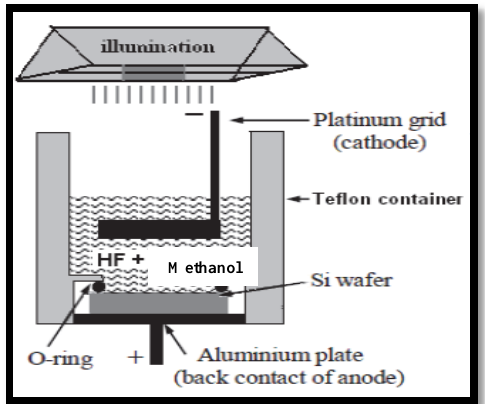
Fig.2: Schematic of the experimental setup of the illumination assisted